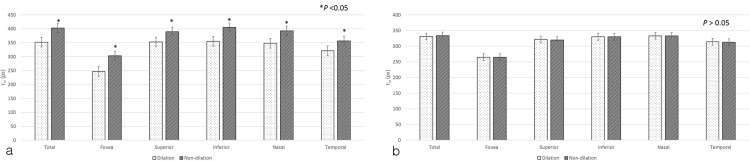
Comparison of mean fluorescence lifetimes from various pre-specified macular regions of both eyes dilated and non-dilated settings.(a; short spectral channel, b; long spectral channel, Mann-Whitney U-test, *P<0.05).